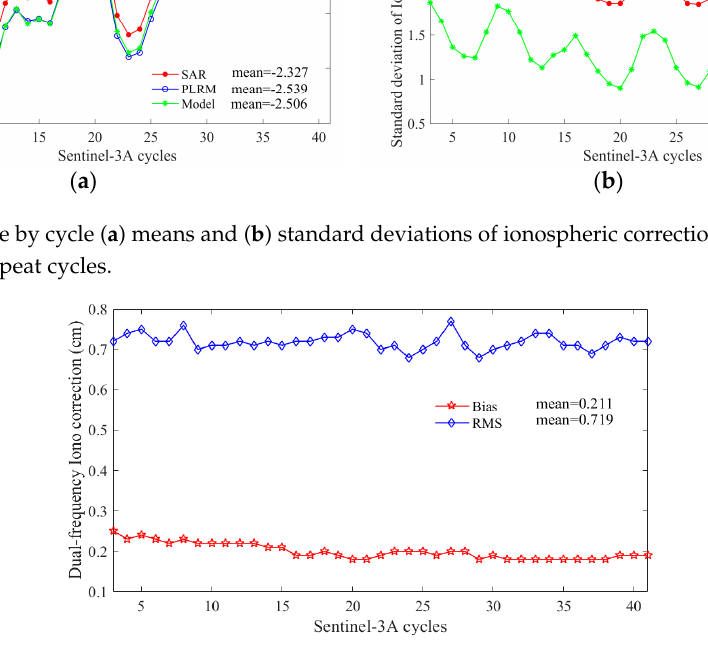
Figure 7. Cycle by cycle biases and RMSEs of differences of dual frequency ionospheric correction between SAR and PLRM mode.